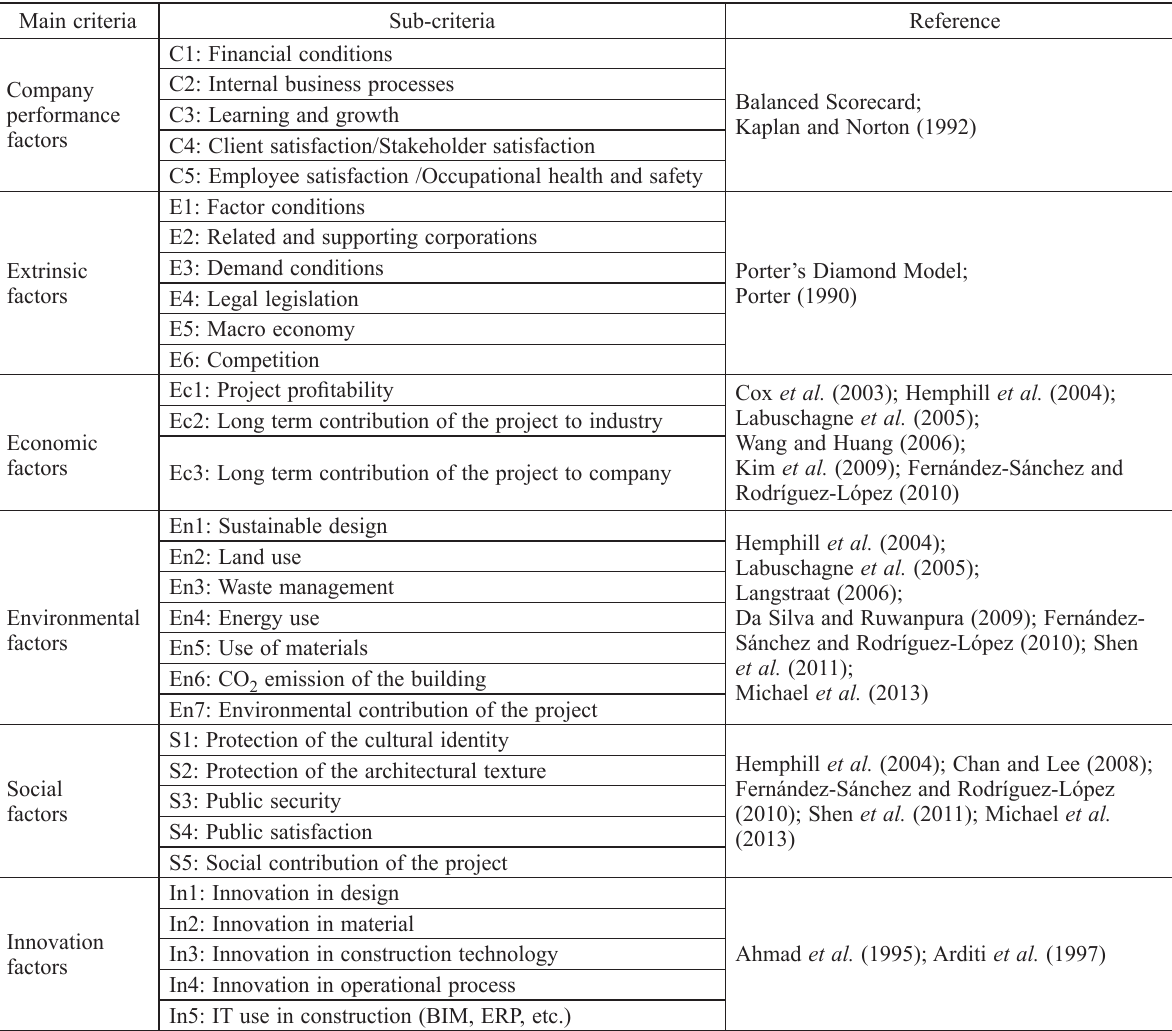
Table 1. Factors affecting the sustainable performance of the construction industry from urban regeneration perspective Main